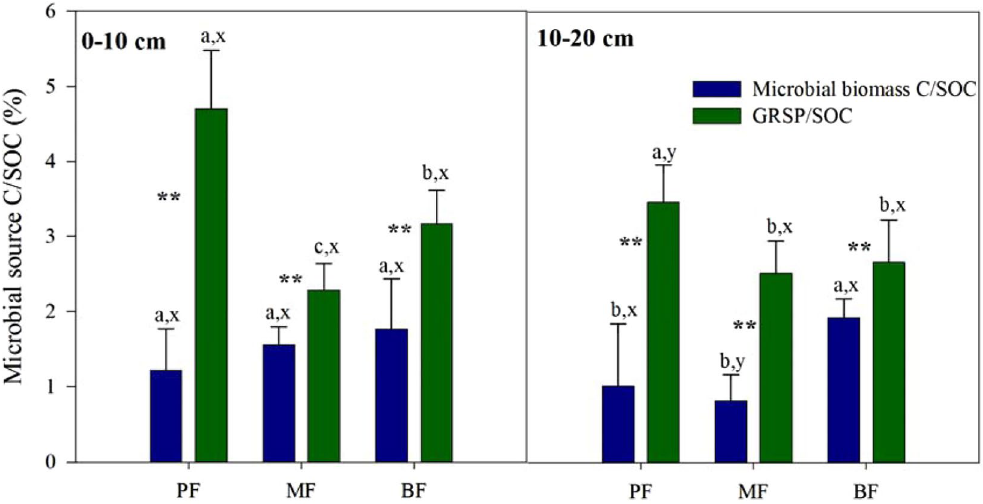
Figure 2. Contributions of microbial biomass C and GRSP to SOC in 0–10 cm soil and 10–20 cm soil in the tropical forests of DBR, southern China. Mean values with standard deviations of 7 replications are presented. Different letters indicate significant differences ( P < 0.05) between the forests (a, b, c) and between the soil depths (x, y), and * or ** indicates significant differences between the contribution of the microbial biomass-C/ SOC and GRSP/SOC at the P = 0.05 or P = 0.01 level,